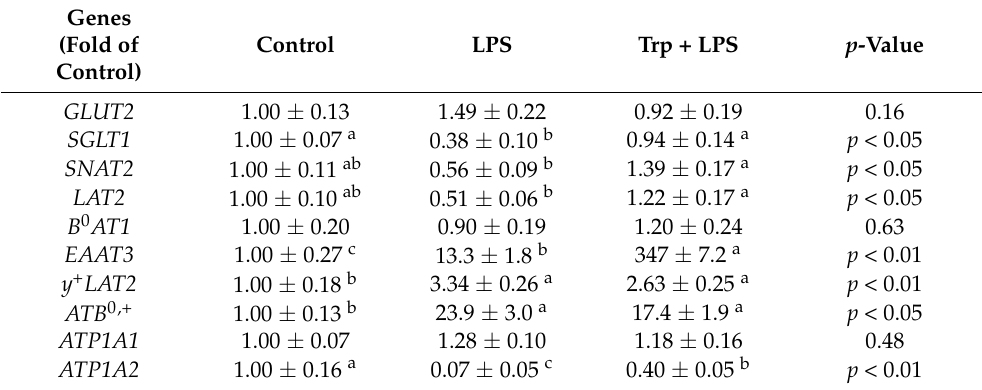
Table 5. Effect of tryptophan supplementation on LPS-induced changes in expression of nutrient transporters 1